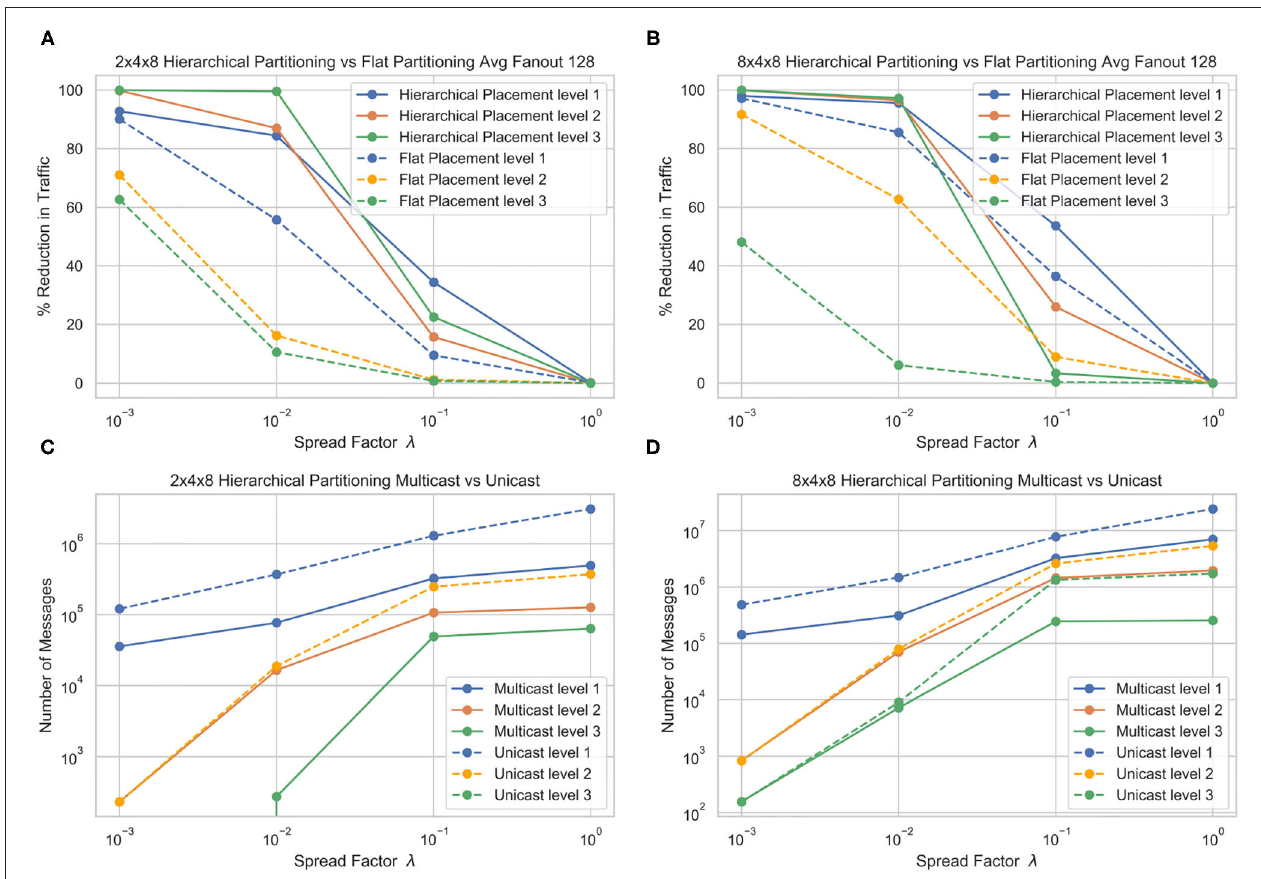
FIGURE 5 | Traffic reduction plots for different hierarchy structures and comparison of cost under two different evaluation methods, for flat core placement (A) and hierarchical (B) core placement. The number of messages generated by multicast (C) and (D) unicast messaging in each layer are also